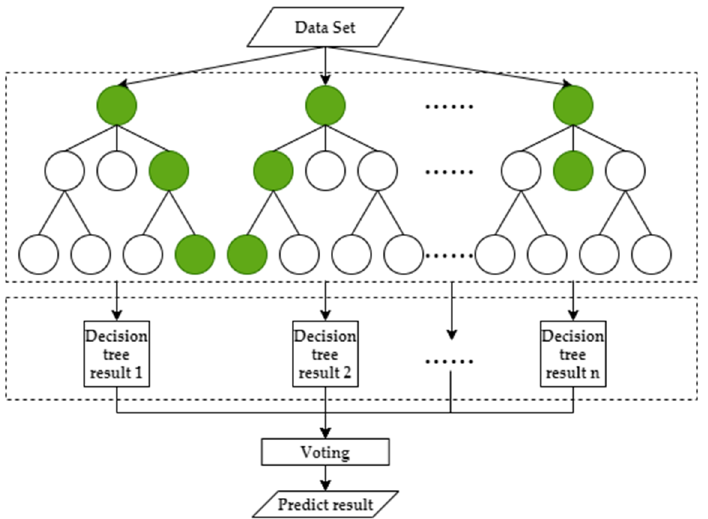
Table 2. Candidate feature factors.